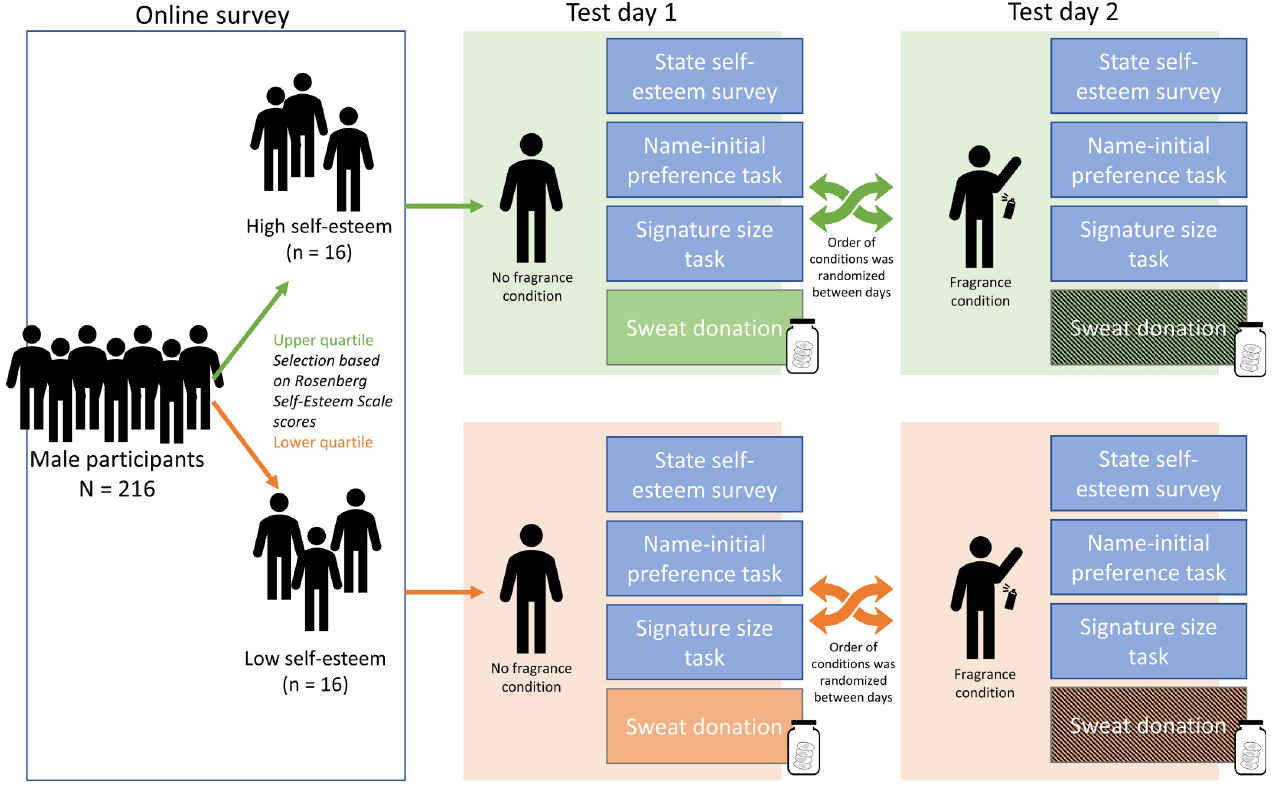
Fig 1. Flow-chart of participant selection and procedure of the sender study.